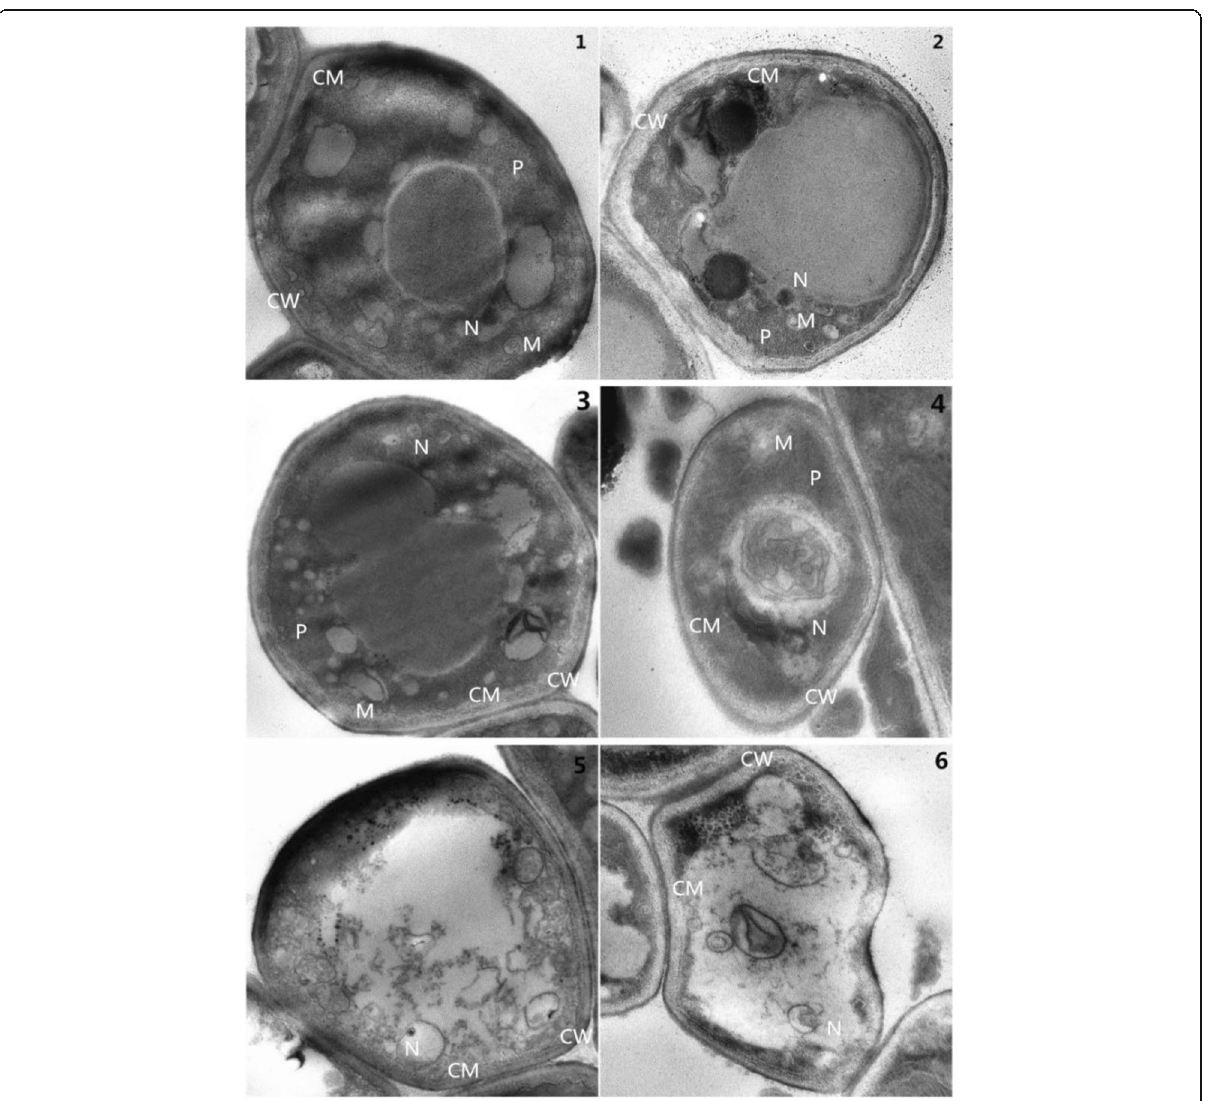
Fig. 4 Effect of extracellular culture supernatant of BM21on ultrastructure of F. graminearum hyphae (magnified × 30,000 times). 1 was non- treated control; 2 , 3 , and 4 indicate after treatment with 1% extracellular culture supernatant; 3 and 4 indicate after treatment with 5% extracellular culture supernatant; 5 and 6 indicate after treatment with 10% extracellular culture supernatant. CW stands for cell wall; CM stands for cytoplasma membrane; M stands for mitochondria; N stands for nucleus; P stands for ribonucleoprotein particle; V stands for